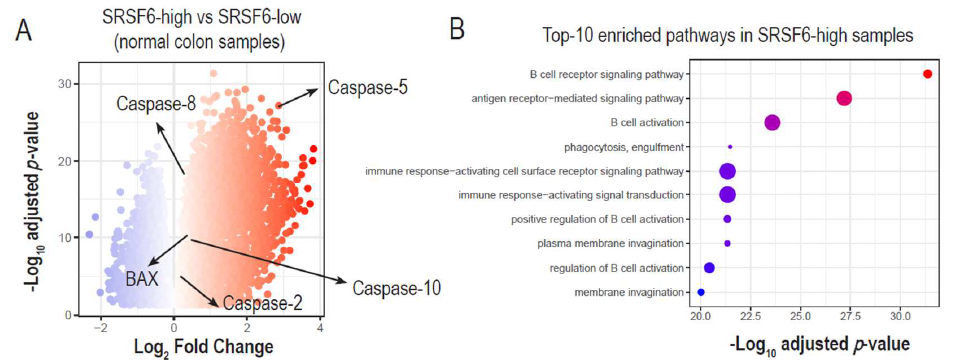
Figure 5. SRSF6 expression in normal samples promotes pro-apoptotic signaling and immune cell activation. ( A ) Based on differential gene expression analysis (R DESeq2), we identified significant expression changes between SRSF6-high and -low colon samples. Log2 fold changes and −log 10-adjusted p -values of differentially expressed genes (DEGs) are shown on the x-axis and y-axis, respectively. (up- and down-regulation were colored red and blue based on fold changes, respectively) ( B ) We performed pathway enrichment analysis of significantly up-regulated DEGs and identified immune cell activation among SRSF6-high normal samples (hypergeometric tests p -values < 0.01). The top 10 enriched pathways are shown with their respective statistical significances (i.e., −log 10 p -value).